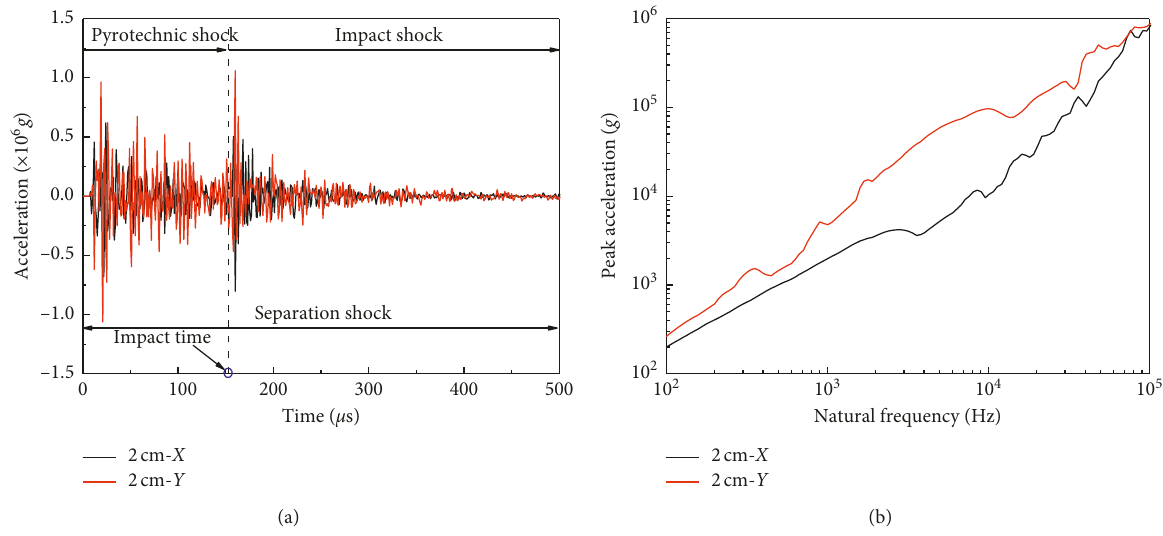
Figure 13: Separation shock in X and Y directions at 2cm under 442mg. (a) Acceleration history. (b) SRS.